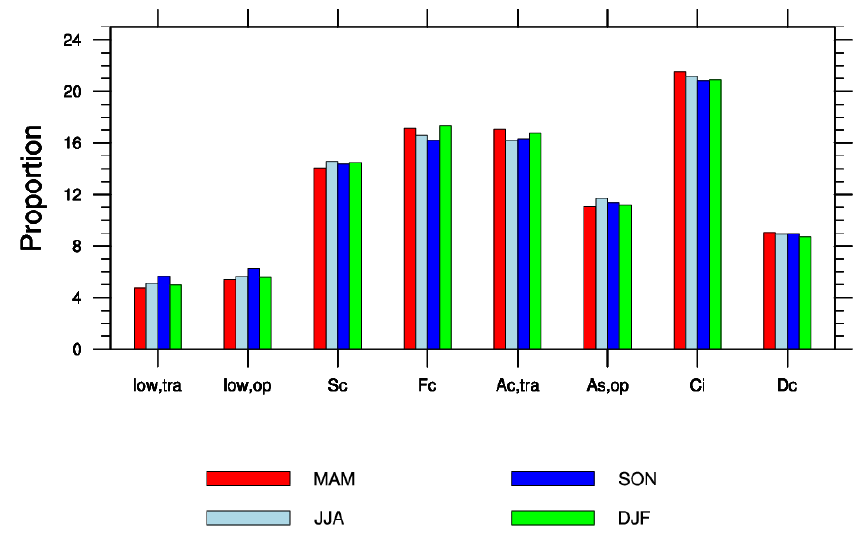
Figure 5. Percentage of cloud type per season (unit: %).